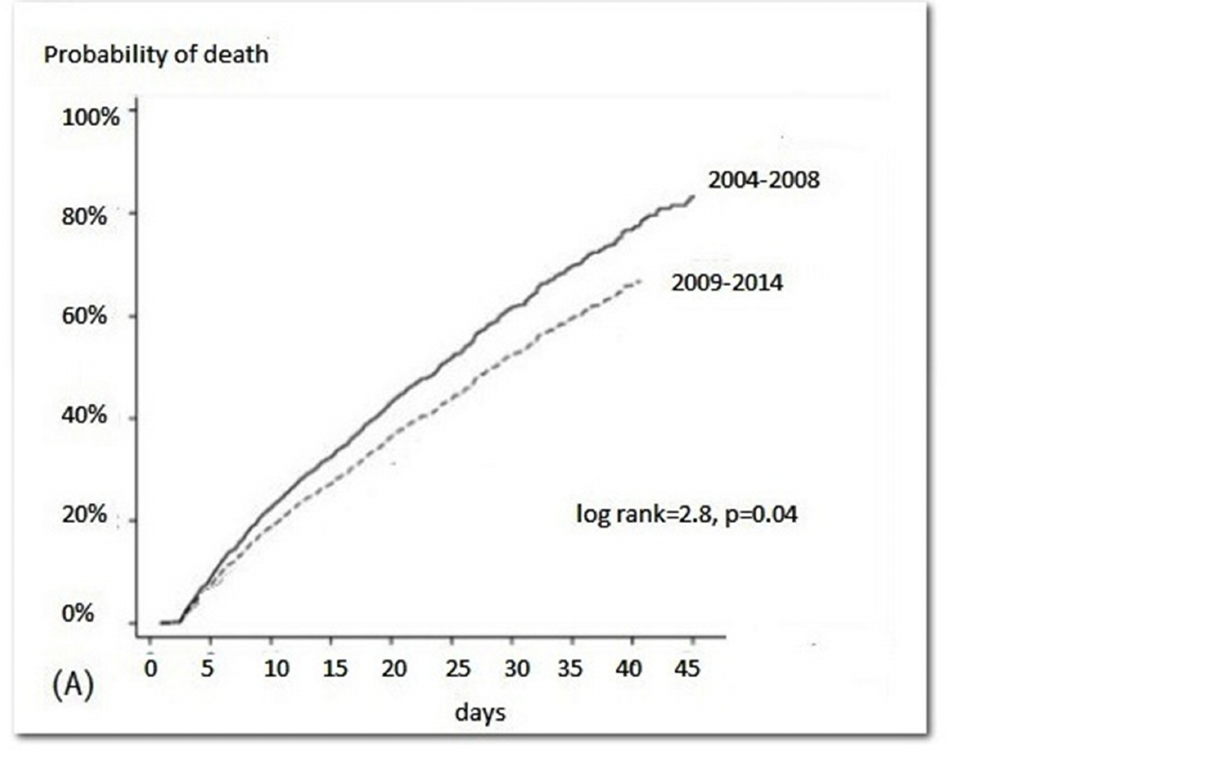
Fig 2. Probability of death according to time period.